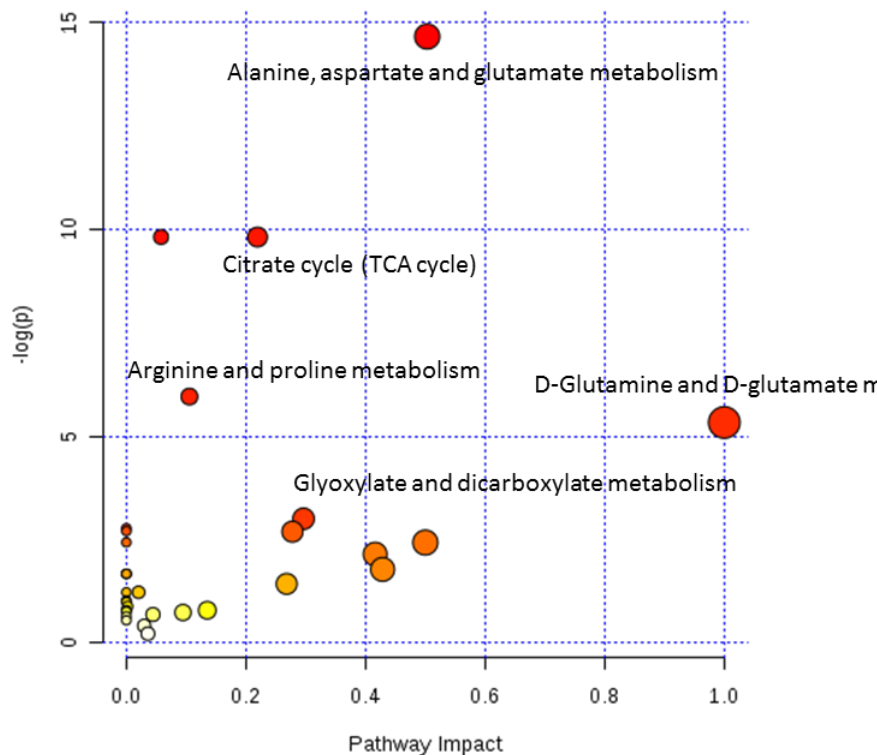
Figure 4. Result of metabolic pathway analysis with MetaboAnalyst. The size and color of each circle represent pathway impact value and p -value, respectively.